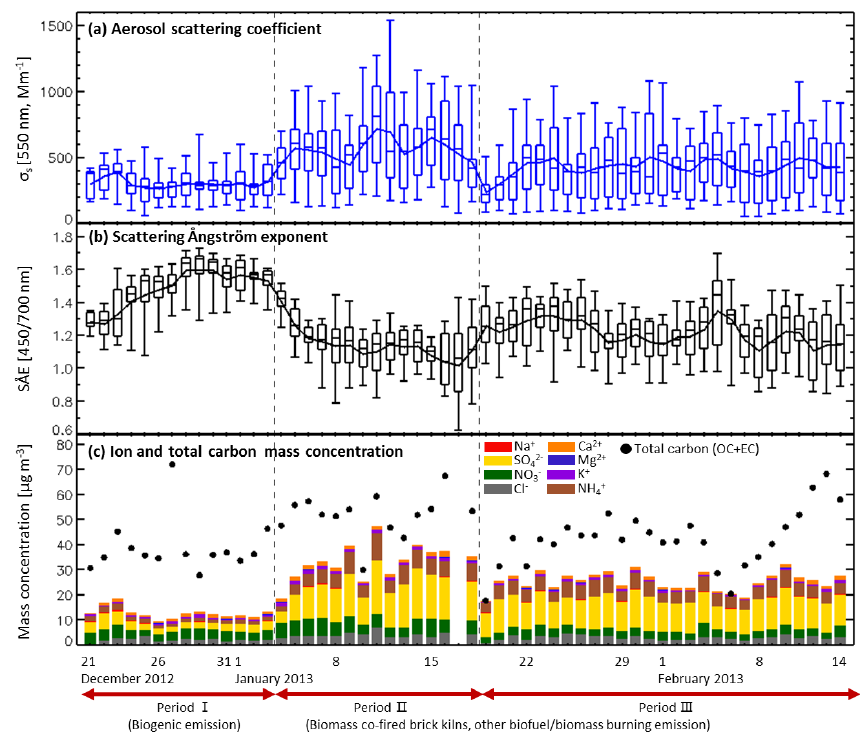
Figure 2. Daily variation in (a) aerosol scattering coefficient, (b) scattering Ångström exponent, and (c) chemical composition of PM 10 at the Bode supersite during the SusKat-ABC campaign. Based on Sarkar et al. (2016), the main source is biogenic emission in Period I (21 December 2012 to 3 January 2013) and biomass co-fired brick kilns and other biofuel/biomass burning emissions in Period II (4– 18 January 2013). Period III is from 19 January to 14 February